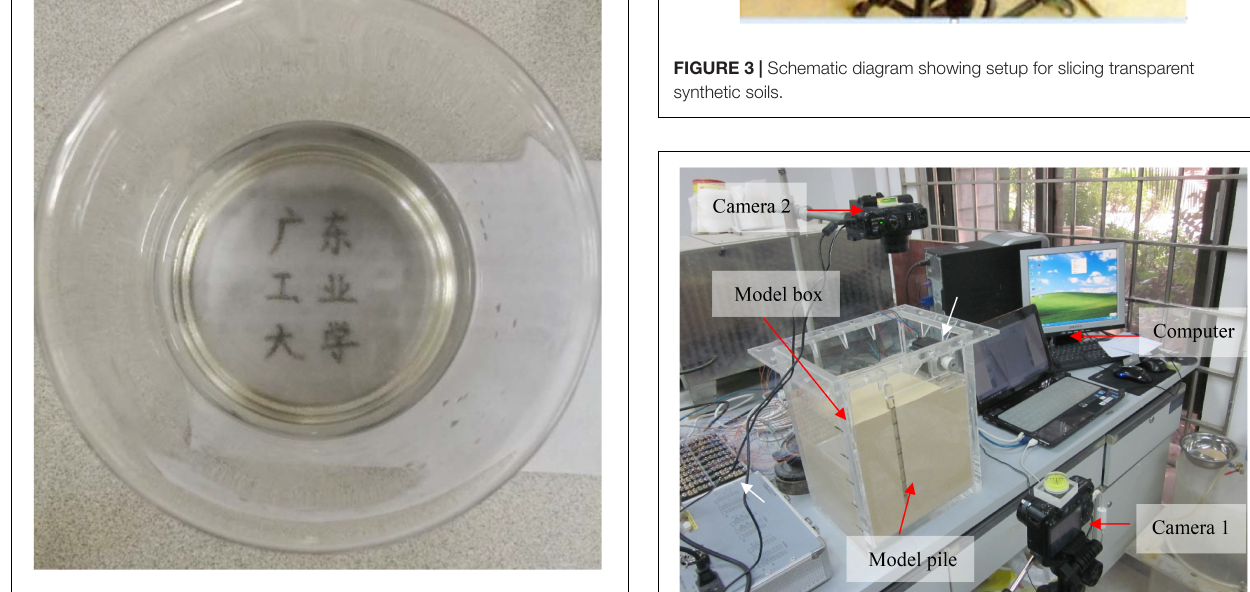
FIGURE 4 | Equipments of the model